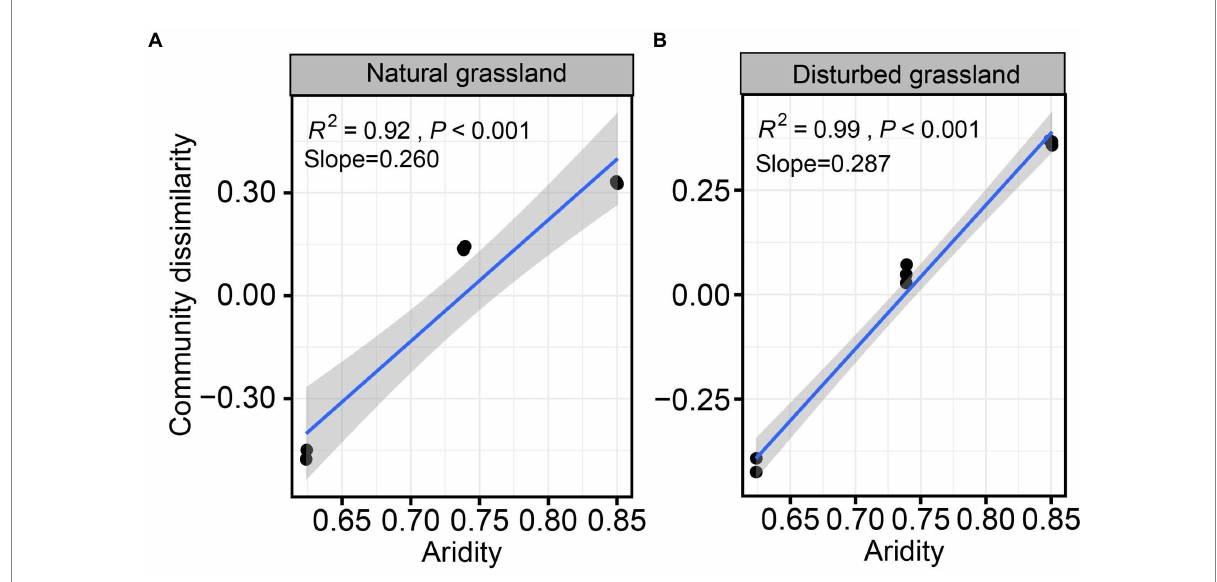
FIGURE 3 Relationships between aridity and soil pqqC community dissimilarity ( β -diversity) in natural (A) and disturbed (B)